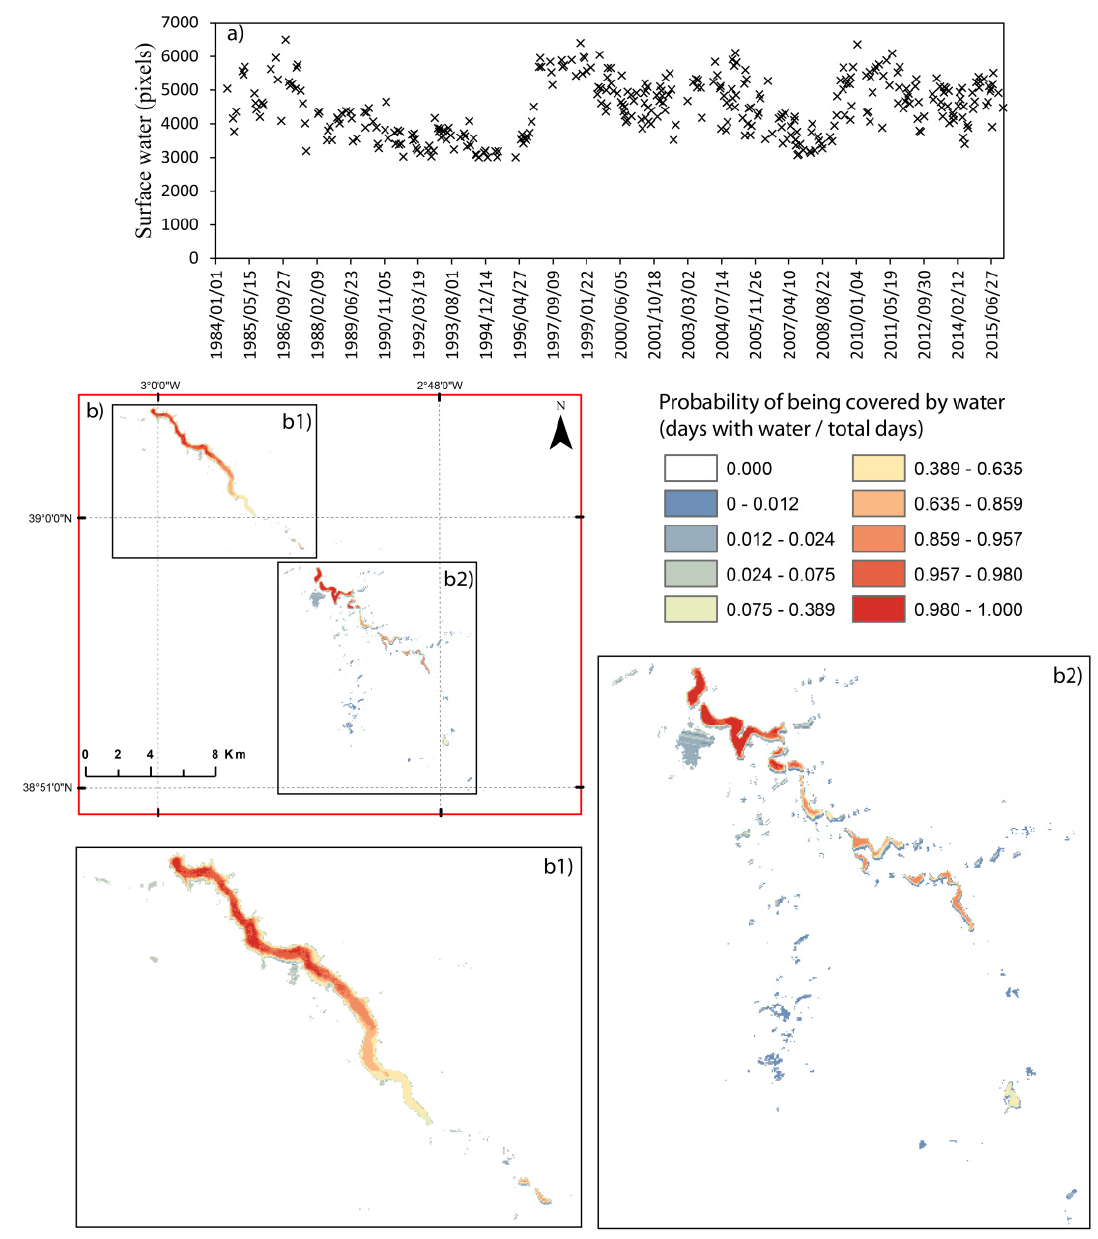
Figure 6. Surface water in the period 1984 to 2015: ( a ) surface water identified by using LANDSAT for the days with available information; ( b ) spatial distribution of the probability of being covered by water (days with water divided by the total days in the studied period) within a pixel. ( b1 ) Zoom in on ( b ) to show the reservoir area, ( b2 ) Zoom in on ( b ) to show the lagoons area.